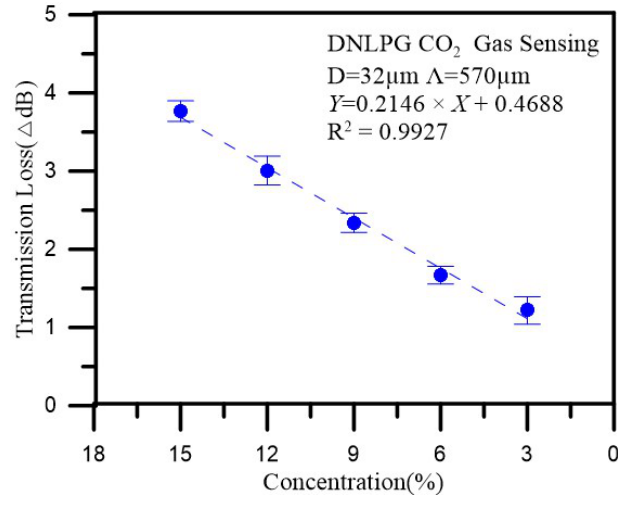
Figure 12. Repeatability of the CO 2 gas sensor spectral analysis. Table 1. Mean and standard deviation changes in loss for the different CO 2 gas concentrations.